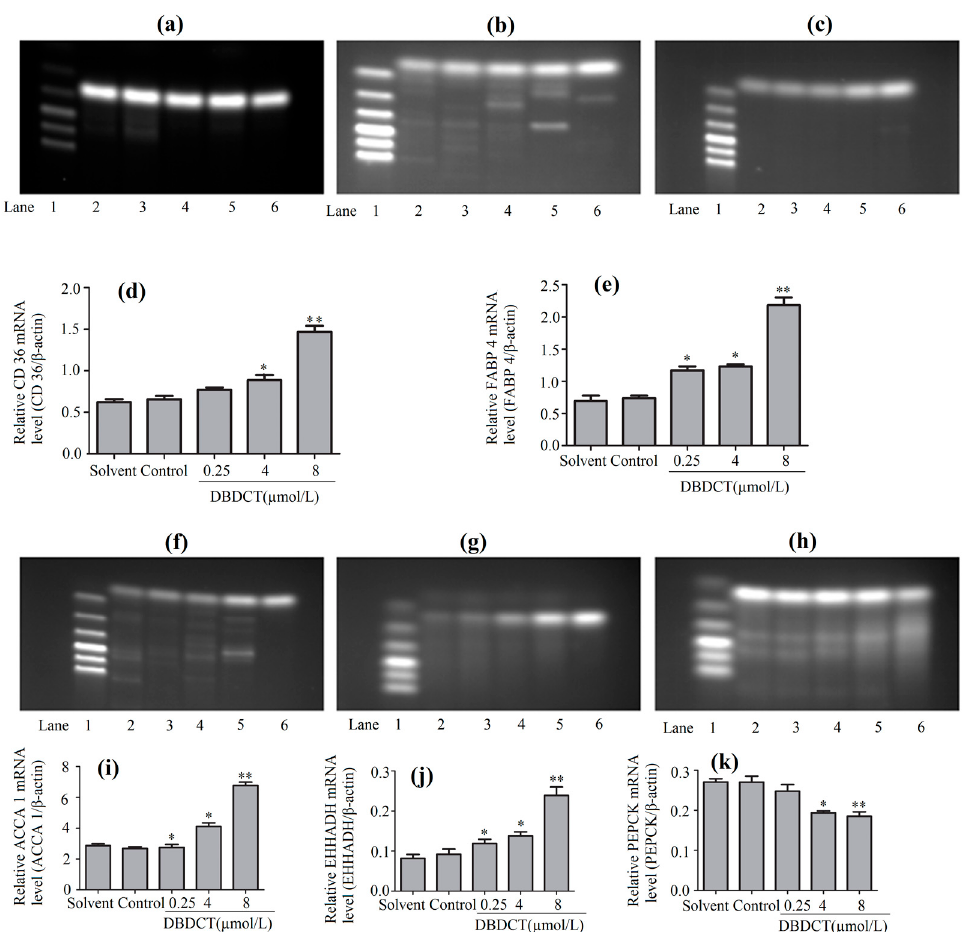
Figure 5. The CD36, FABP4, ACAA1, EHHADH and PEPCK expression levels of mRNA in BRL cells with the treatment of DBDCT (0.25, 4, and 8 µ mol/L). ( a – c , f – h ) The RT-PCR results of β -actin, CD36,